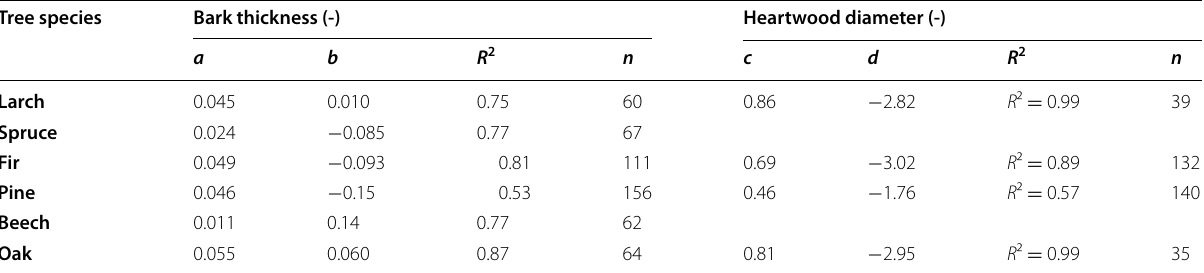
Table 7 Regression coefficients in the correlation of bark thickness (B wood including bark (D ), according to Eqs. (3) and (4). Note that heartwood is not distinguished for Norway spruce and beech. For ob silver birch, insufficient measurements of bark thickness were available Tree species Bark thickness (-)